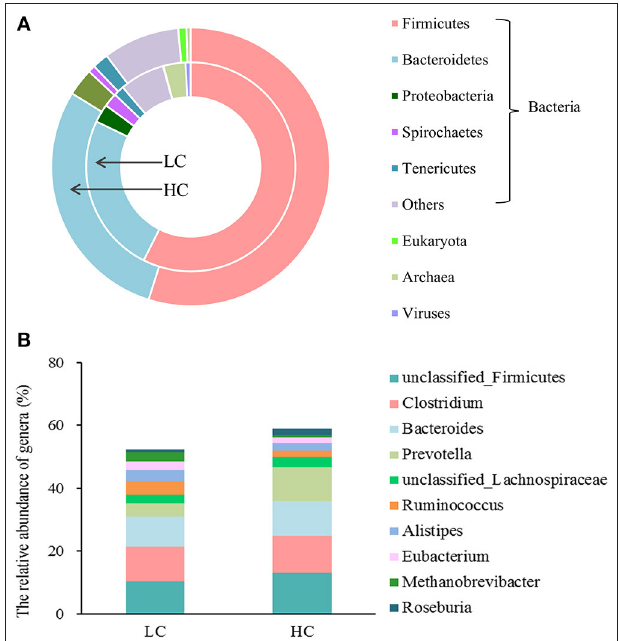
FIGURE 1 | The overview of the fecal microbial composition of dairy cows at the level of the kingdom (A) and genus (B) . Only the 5 most abundant phylum and the 10 most abundant genera in bacteria were shown in the